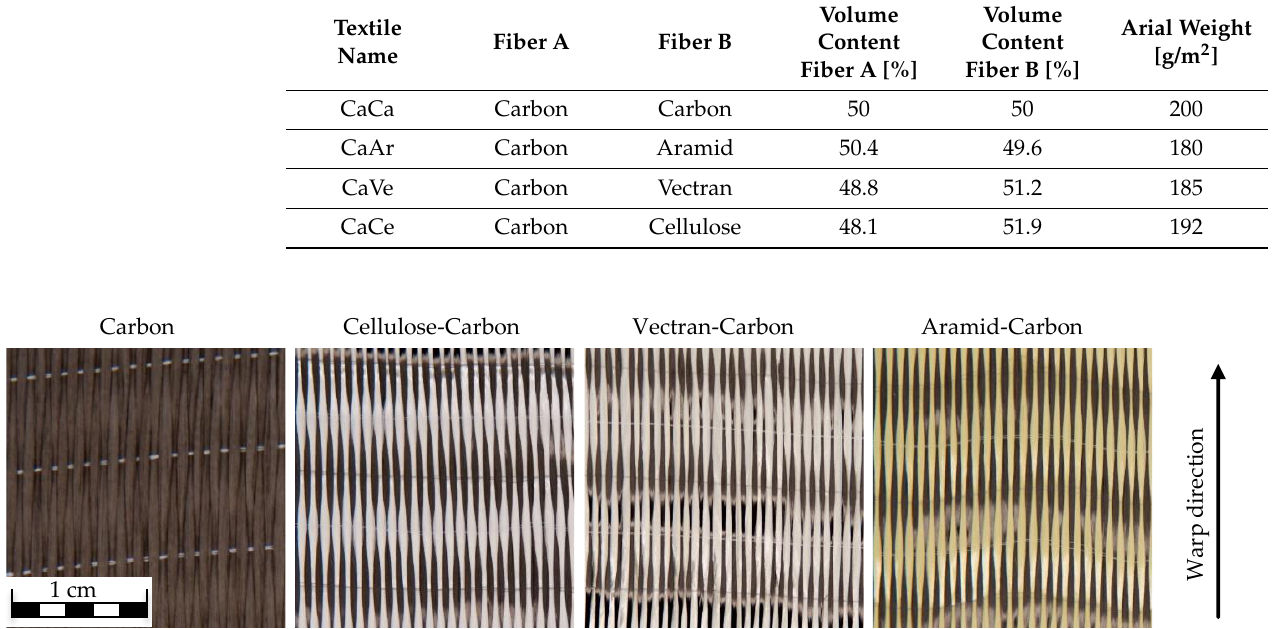
Figure 3. Hybrid and non-hybrid UD-fabrics produced.